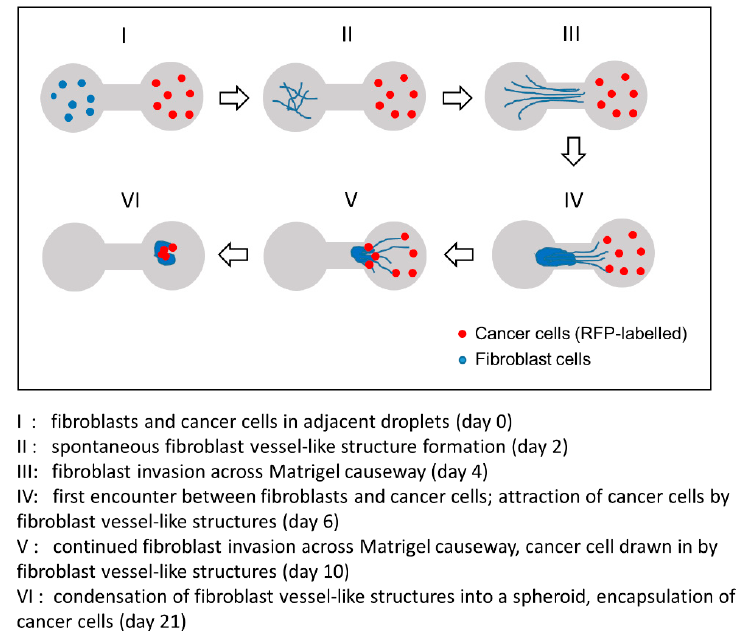
Figure 8. Schematic representation of a fibroblast-guided cancer cell migration event captured with